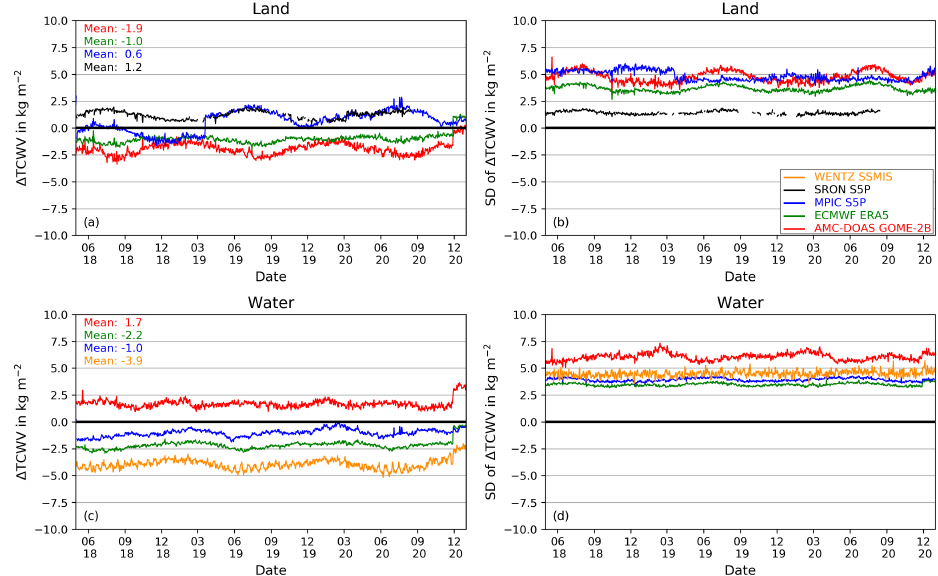
Figure 7. Time series of the daily averaged difference between TCWV AMC , S5P and TCWV from other data sets over land (a) and water (c) surface from May 2018 to December 2020. The right panels show the respective standard deviation over land (b) and water (d) .